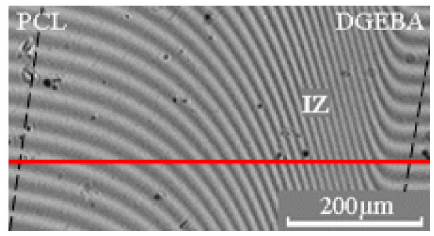
Figure 2. Interferogram of the interdiffusion zone of the PCL–DGEBA system at 80 ◦ C. IZ is the interdiffusion